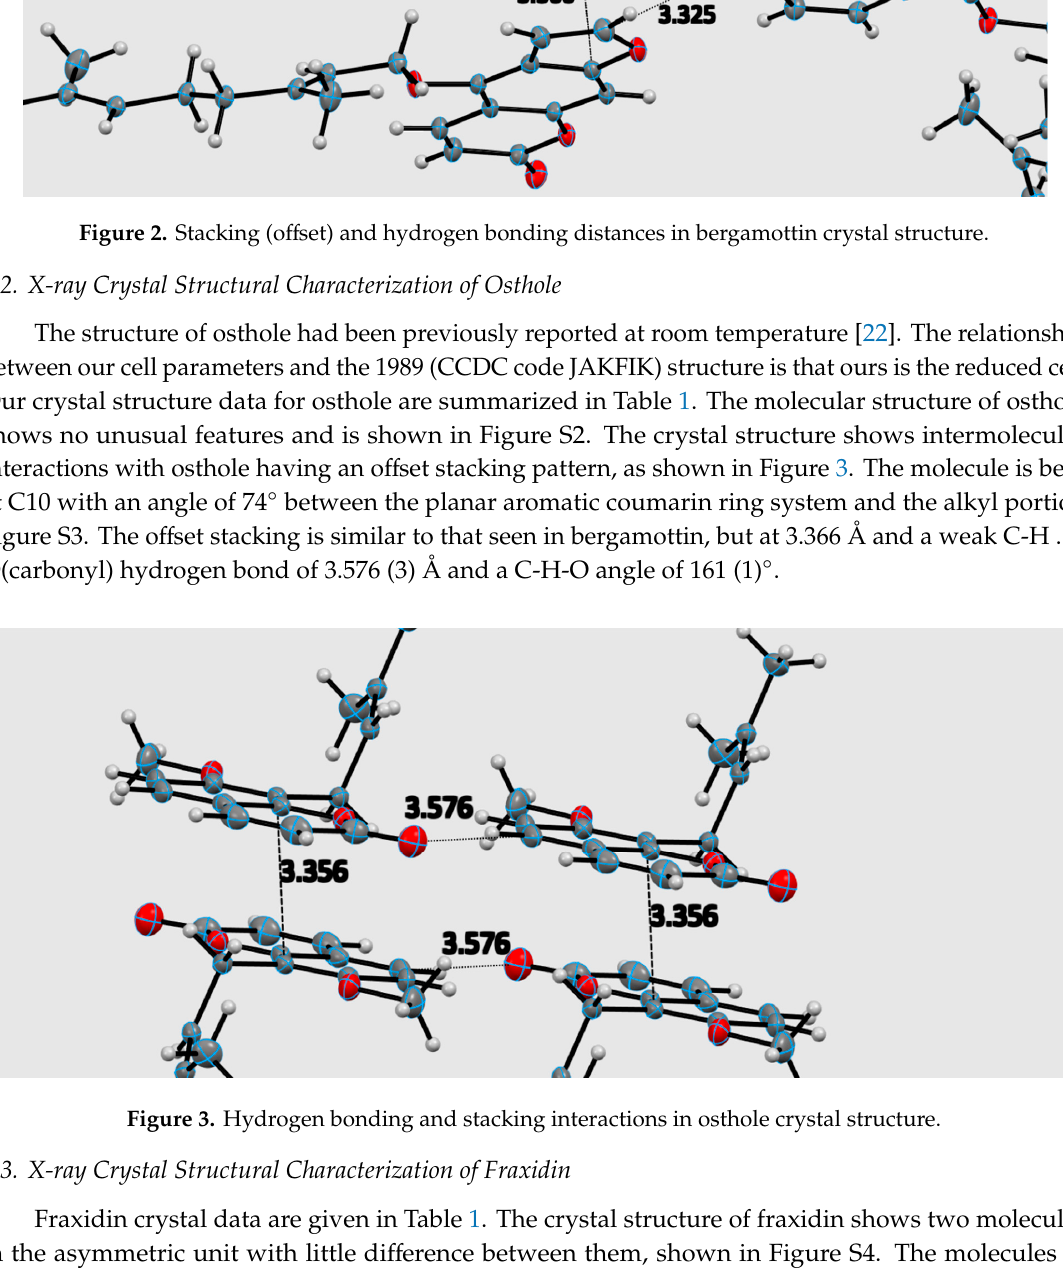
Figure 2. Stacking (offset) and hydrogen bonding distances in bergamottin crystal structure.